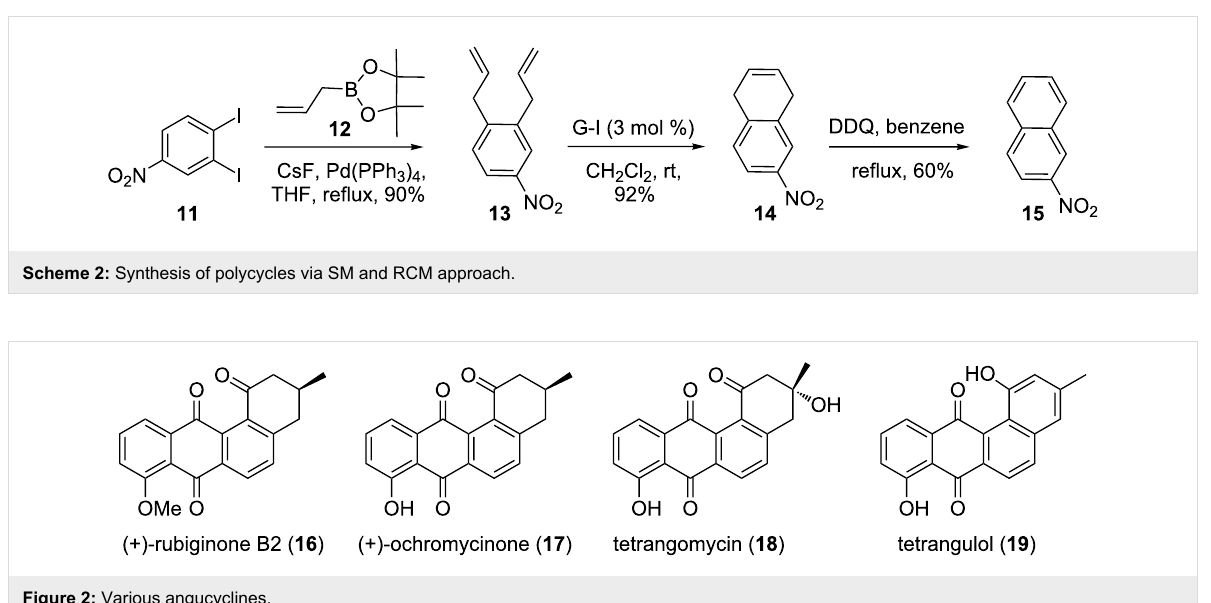
(2-formyl-4-methoxyphenyl)boronic acid ( 21 ) in the